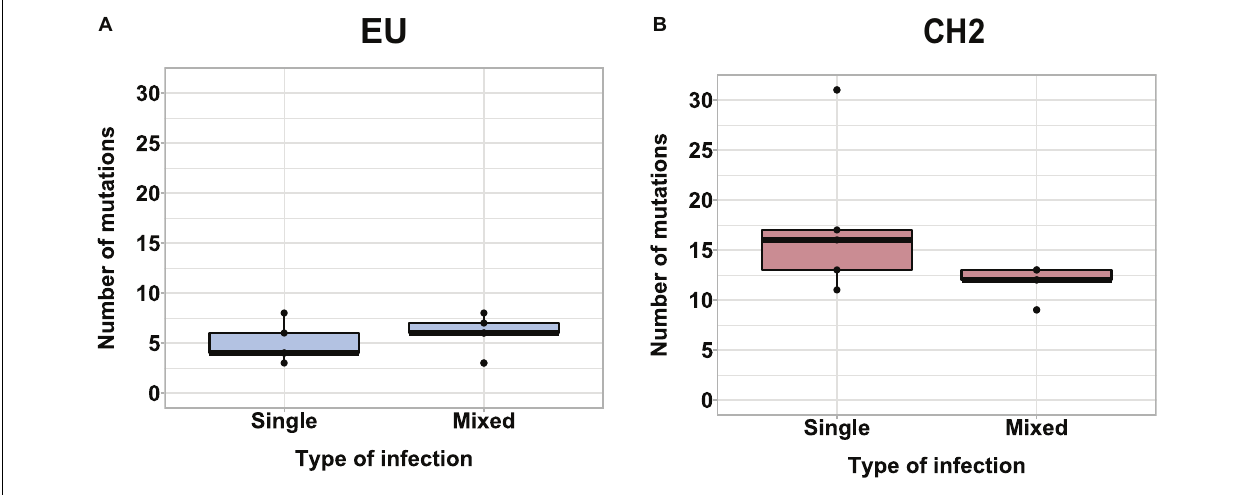
FIGURE 7 | Boxplot showing the average number of mutations for PepMV-EU (A) and PepMV-CH2 (B) in single and mixed infections pooling together sequences from all the passages of the evolution experiment (see the diagram in Figure 5A ).